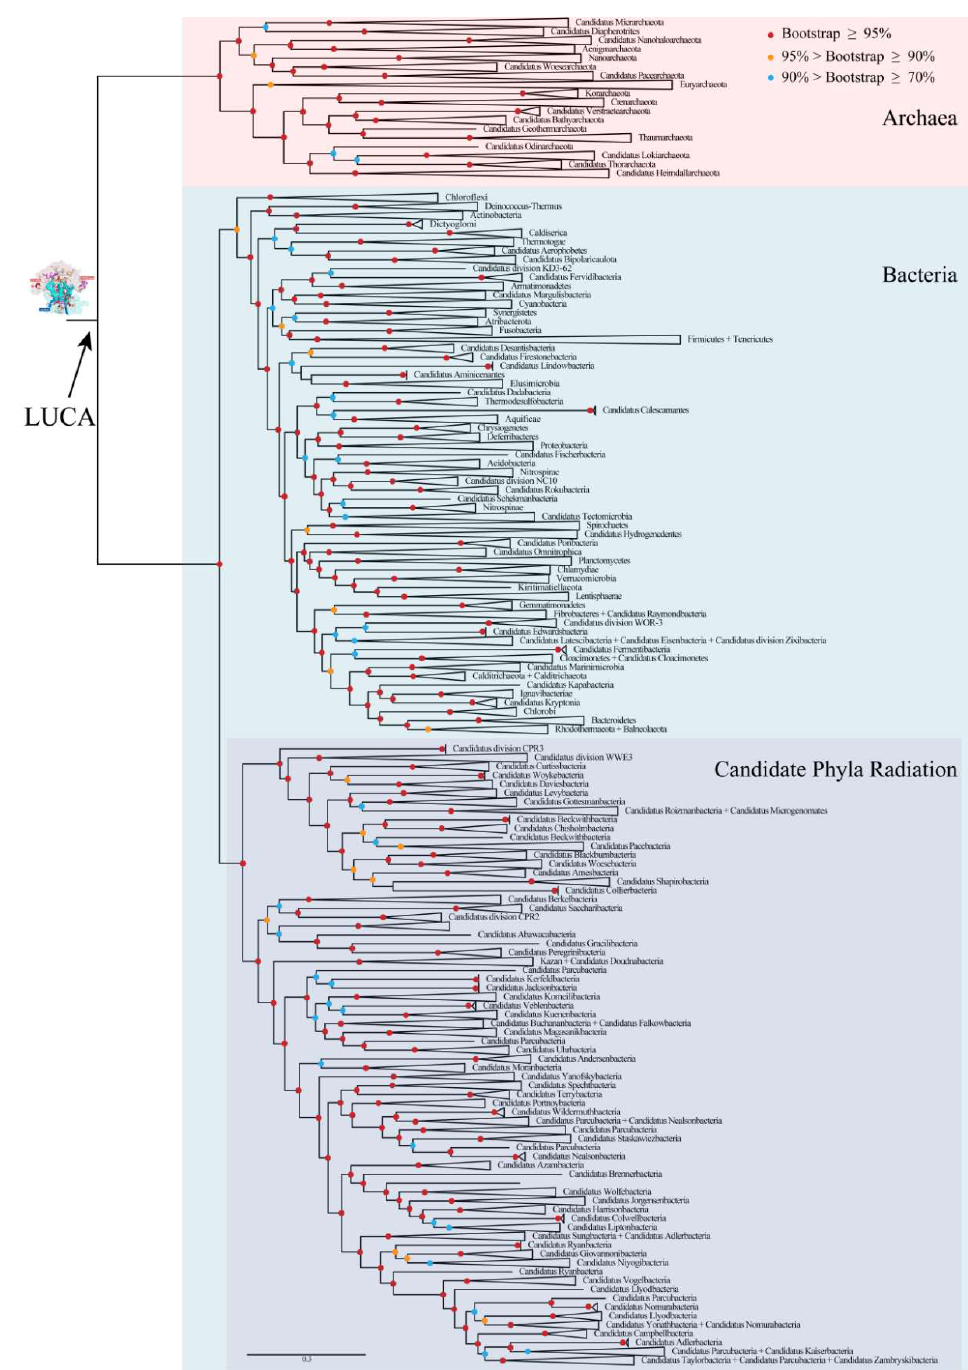
Figure 2. Phylogenetic relationships of archaea and bacteria. Branches were grouped to display the tree at the phylum level. Bootstrap values for this ML(Maximum Likelihood) tree were indicated by colored circles on nodes. LUCA: last universal common ancestor. The ML-tree with all branches is shown in Figure S1.